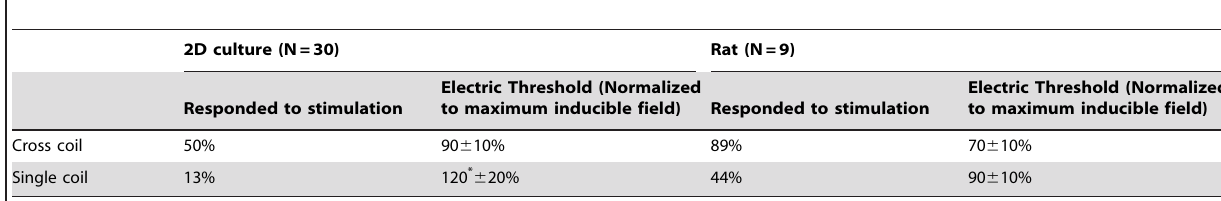
Cross coil 89% 70 6 10% Single coil 13% 44% 90 6 10% All distribution errors are standard error (SE). % denotes fraction of the maximum attained rotating electric field. *When using only our home made stimulator as the single coil we can induce non-rotating electric fields that are up to 2 times stronger than the maximum rotating electric field.